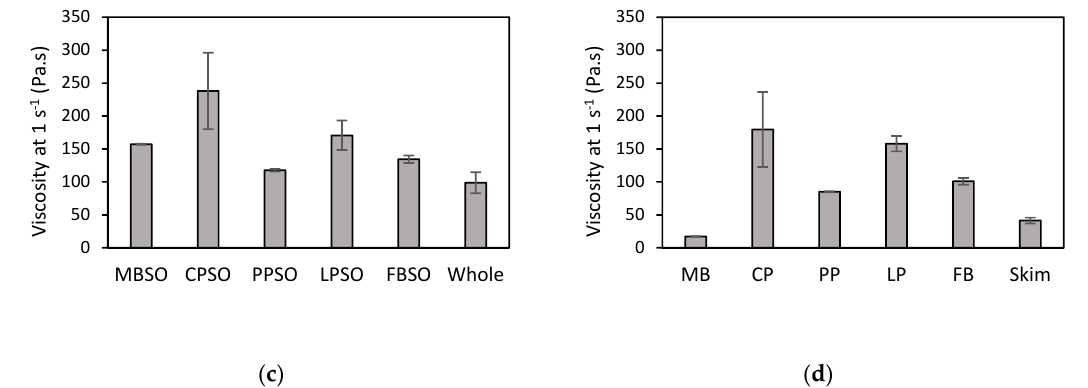
Figure 3. Flow curves ( a , b ) and viscosity at 1 s − 1 ( c , d ) of high pressure-treated 12% ( w / w ) mung bean (MB), chickpea (CP), pea (PP), lentil (LP), and faba bean (FB) protein samples without and with 5% ( w / w ) sunflower oil (SO) as compared to commercial plain skim and whole milk Greek yogurt. Each curve is the average of two treatments. The average of two treatments is presented with the error bar extremes showing the data for each treatment.